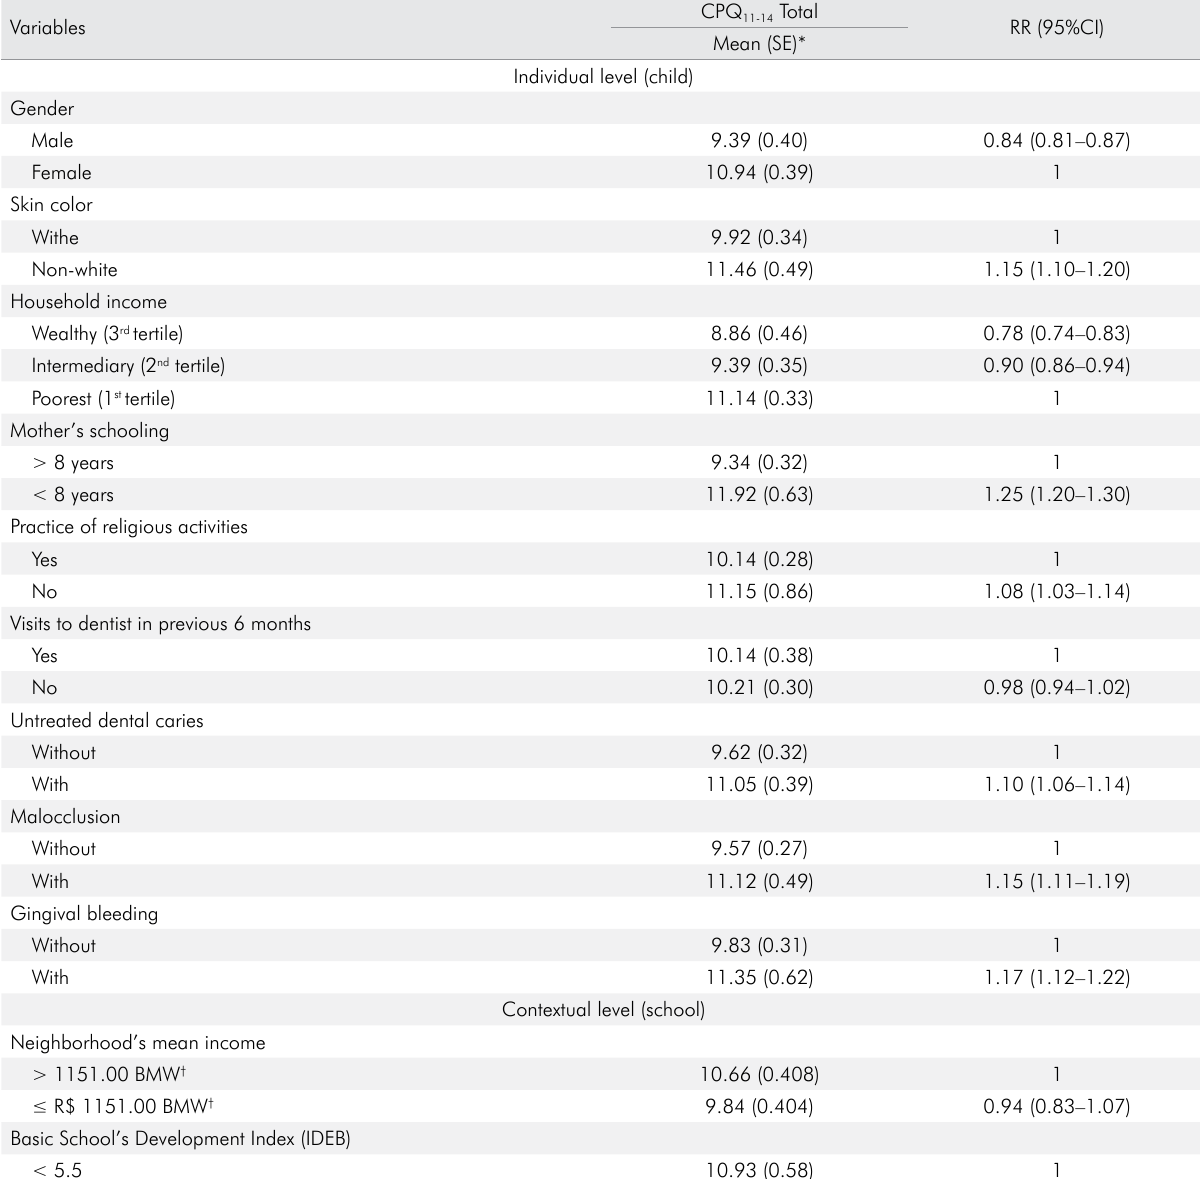
Table 3. Individual and contextual factors associated whit CPQ11–14 averages - Unadjusted Multilevel Analysis: 1,134 12-year- old children, Santa Maria – RS,